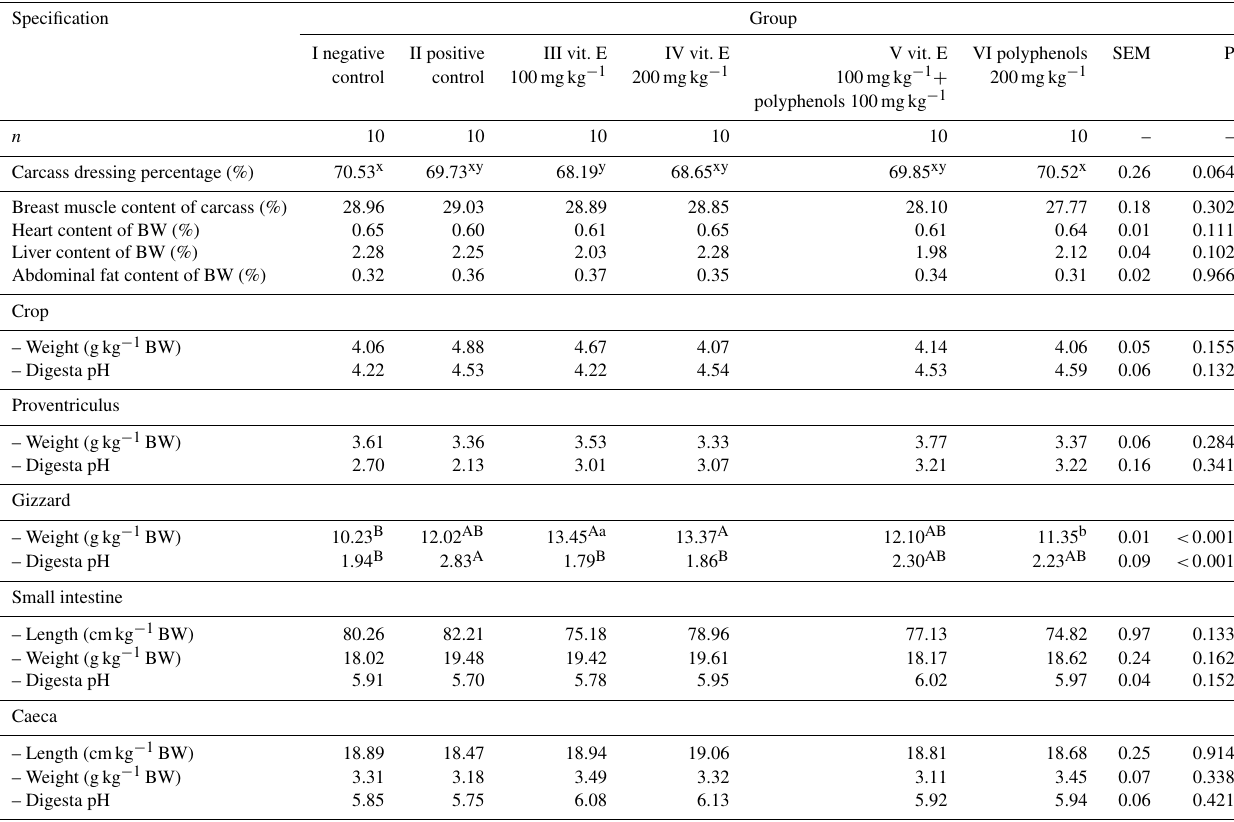
Table 5. The effect of antioxidants on carcass quality, structure of the gastrointestinal tract and digesta pH in broiler chickens fed low-quality oil. BW stands for body